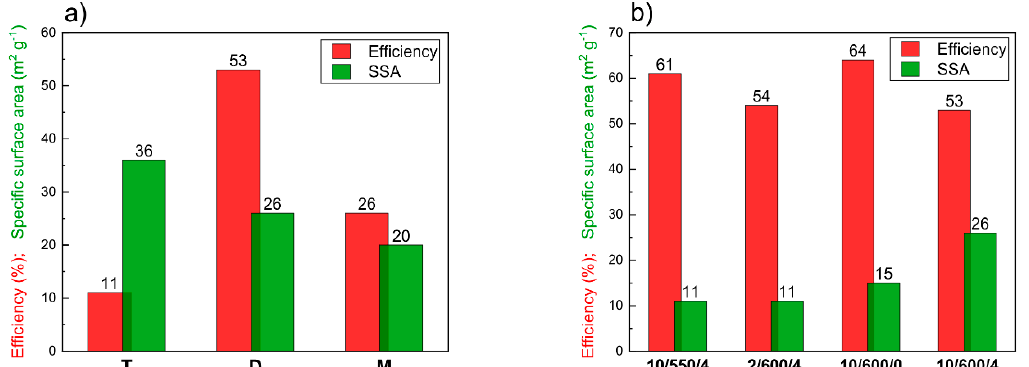
Figure 2. ( a ) Influence of the precursor on the synthesis efficiency and the specific surface area of carbon nitrides synthesized under conditions 10/600/4 (10 °C min − 1 , 600 °C, 4 h); T–thiourea, D–dicyandiamide, M–melamine. ( b ) Influence of condensation conditions on the synthesis efficiency and specific surface area of carbon nitrides obtained by condensation of dicyandiamide.